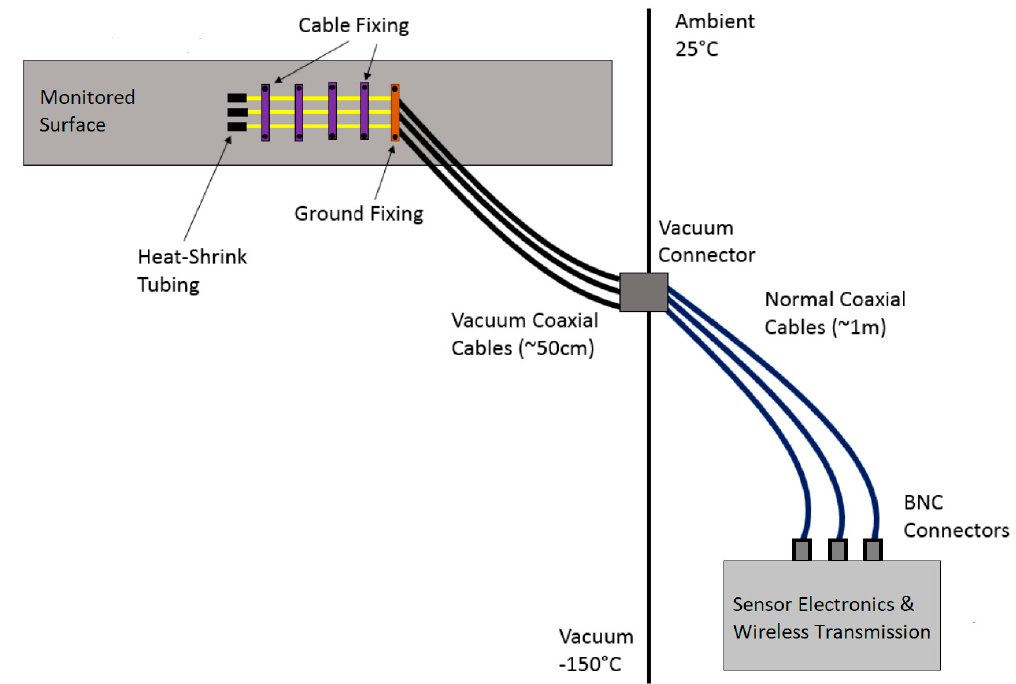
Figure 5. Overview of the proposed measurement system.